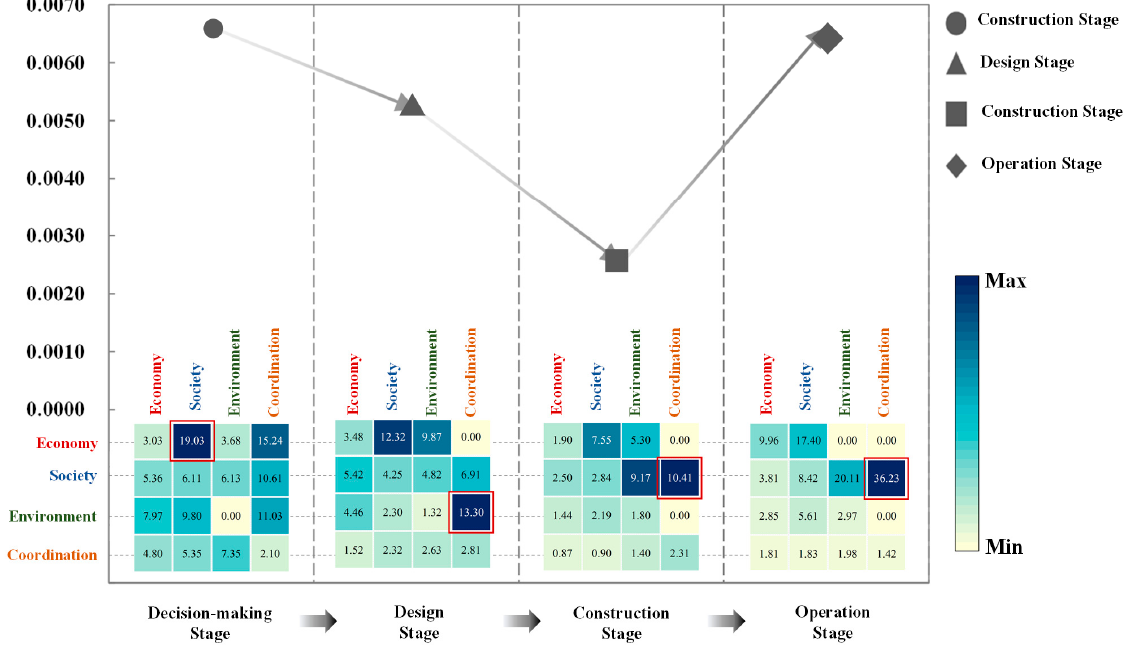
Figure 6. The evolution of link betweenness centrality. (Note: Because the value of link betweenness centrality is too small, to show the results clearly, all link betweenness centrality in the heat map is multiplied by 1000).